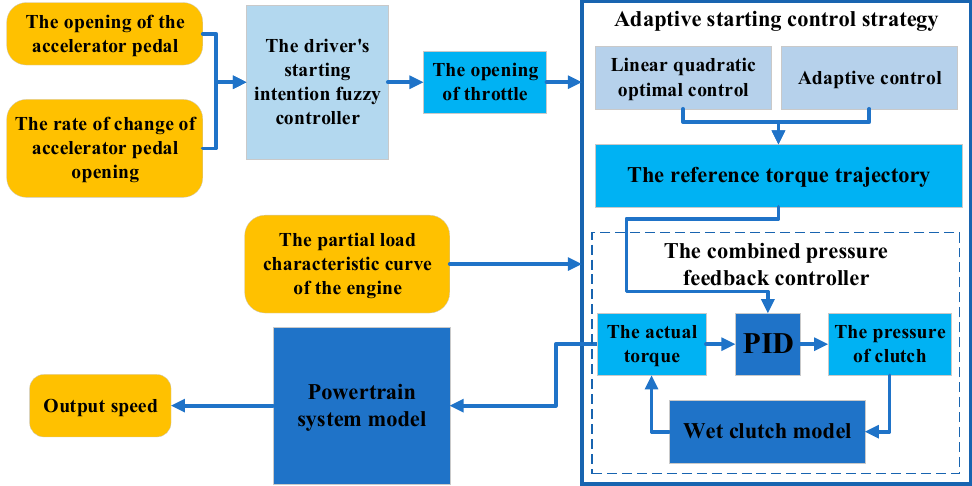
Figure 4. Block diagram of the starting control strategy.